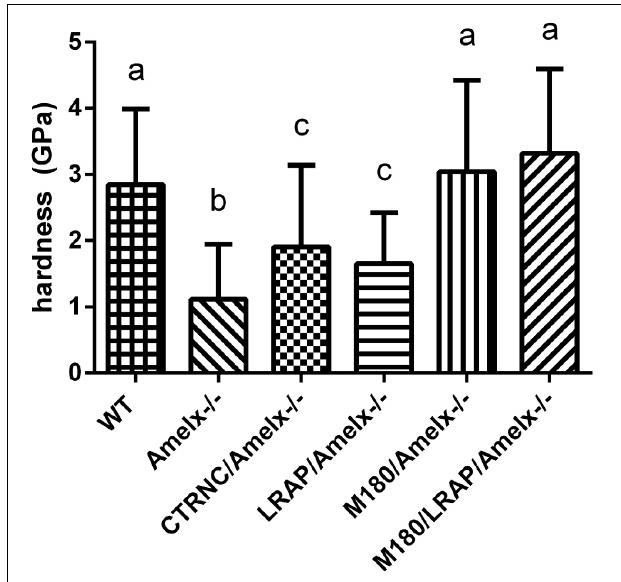
FIGURE 3 | Mouse molar enamel hardness measured by nanoindentation. WT, M180/Amelx − / − , and M180/LRAP/Amelx − / − (a) were not different from each other but were significantly harder than CTRNC/Amelx − / − (c), LRAP/Amelx − / − (c) and Amelx − / − (b) enamel ( p < 0 . 05). CTRNC/Amelx − / − and LRAP/Amelx − / − (c) were not different from each other but were significantly harder than Amelx − / − enamel ( p < 0 . 05).